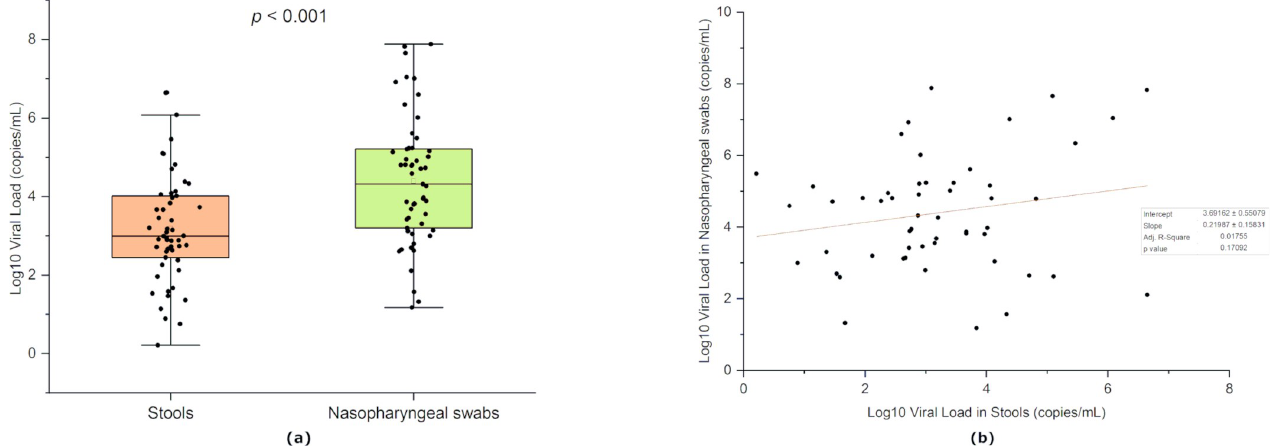
Fig 3. Comparison between viral loads in stools and nasopharyngeal swabs. ( a ) Comparison of the viral load in stools and nasopharyngeal swabs of cases that tested positive in both samples; ( b ) linear regression analysis of the log10 viral load for each case in stools (X-axis) against the log10 viral load in nasopharyngeal swab (Y-axis). The graph presents the median and the minimal to the maximal range of viral load in log10 copies/mL. The significance of the pairwise two-sided t-tests is indicated on top.